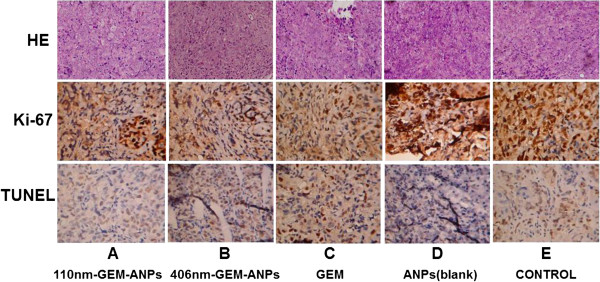
Histological analysis of neoplastic masses by H & E staining, Ki-67 protein, and TUNEL assay after being excised from the PANC-1-induced nude mice tumor model following their scarification at the end of the experiments. A 110nm-GEM-ANPs, B 406-nm-GEM-ANPs, C gemcitabine, D ANPs and E control.